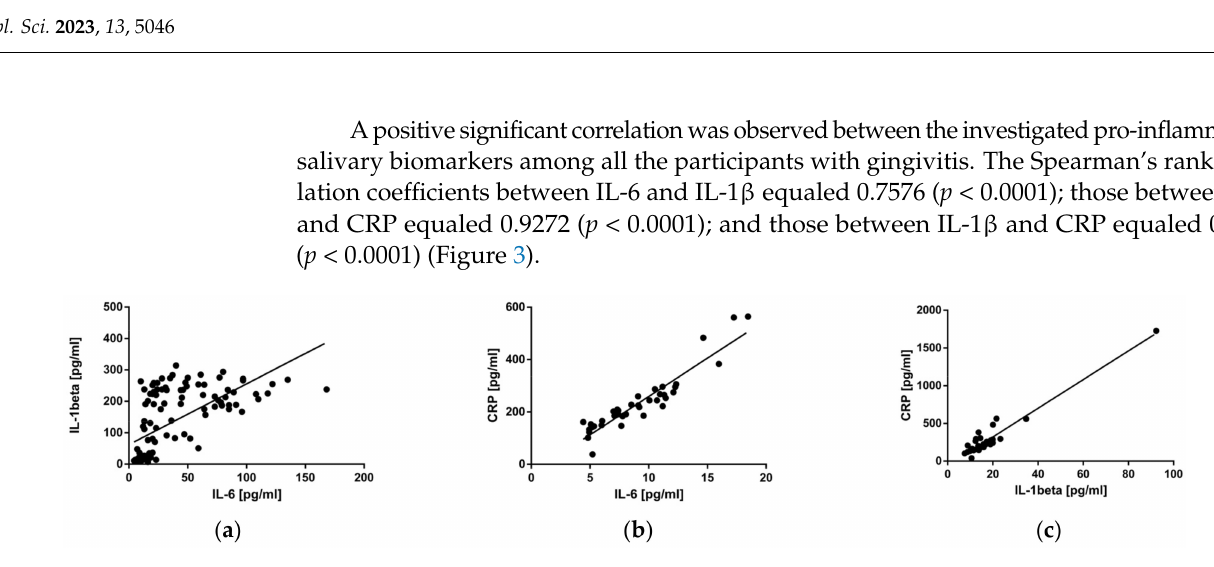
Figure 3. Spearman (cid:48) s correlations between ( a ) IL-6/IL-1 β , ( b ) IL-6/CRP and ( c ) IL-1 β /CRP in the saliva of children with PIG. Abbreviations: IL-6—interleukin-6, IL-1 β —interleukin-1 β , and CRP—C-reactive protein.